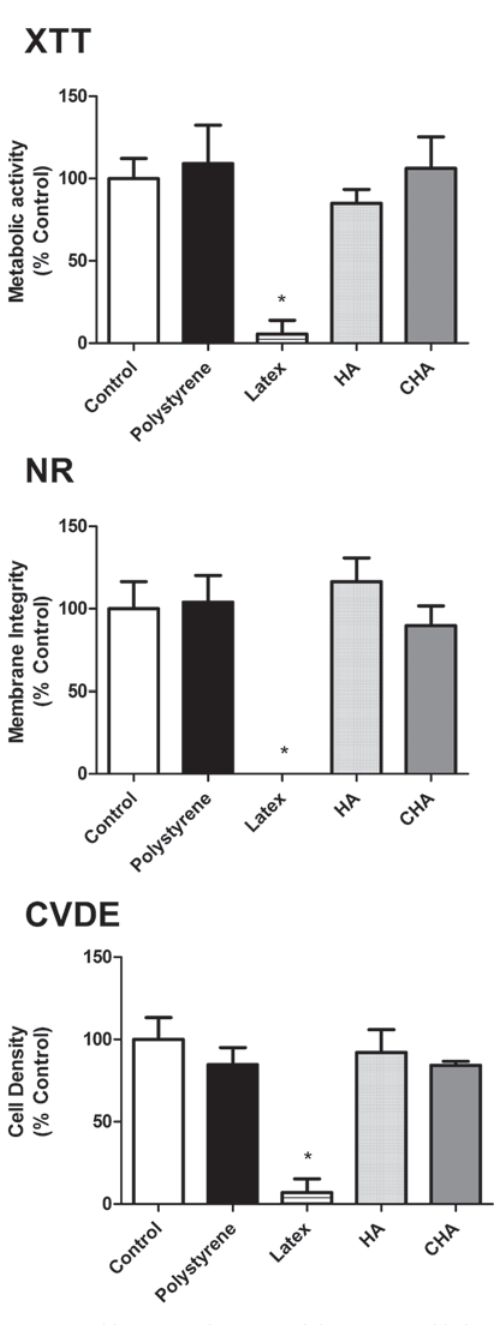
Figure 5- Multiparametric cytotoxicity assay with human osteoblastic cells. Results showed as percentage of (cid:70)(cid:82)(cid:81)(cid:87)(cid:85)(cid:82)(cid:79)(cid:3)(cid:74)(cid:85)(cid:82)(cid:88)(cid:83)(cid:3)(cid:11)(cid:38)(cid:82)(cid:81)(cid:87)(cid:85)(cid:82)(cid:79)(cid:30)(cid:3)(cid:72)(cid:91)(cid:83)(cid:82)(cid:86)(cid:88)(cid:85)(cid:72)(cid:3)(cid:87)(cid:82)(cid:3)(cid:39)(cid:48)(cid:40)(cid:48)(cid:12)(cid:17)(cid:3)(cid:13)(cid:3)(cid:143)(cid:3)(cid:68)(cid:79)(cid:79)(cid:3)(cid:87)(cid:75)(cid:72)(cid:3) other groups